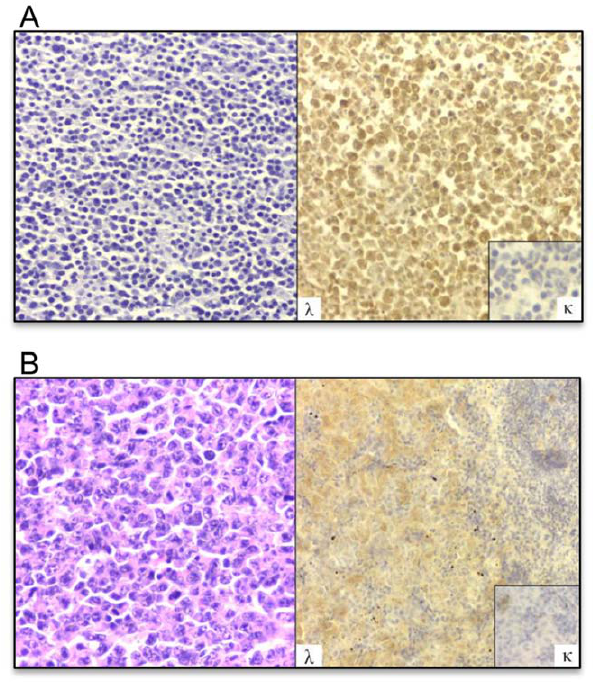
Figure 4. Histology and immunostaining of organs from paraplegic BALB/c mice injected with 5 6 10 5 MOPC315.BM (IgA l 2 315 ) cells i.v. (A) Bone marrow. Left: H&E staining. Right: Immunostaining with anti- l or anti- k (inset) antibodies, developed by HPRO (brown). (B) Spleen, red pulp. Left: H&E staining. Right: Immunostaining with anti- l or anti- k (inset) antibodies.